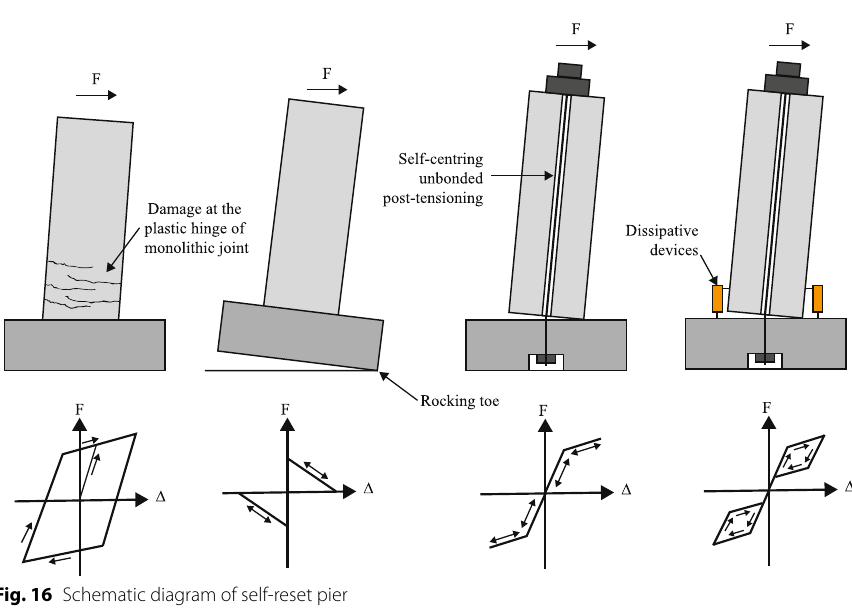
Fig. 16 Schematic diagram of self-reset